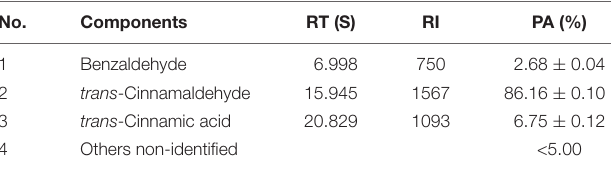
TABLE 1 | Chemical compositions of